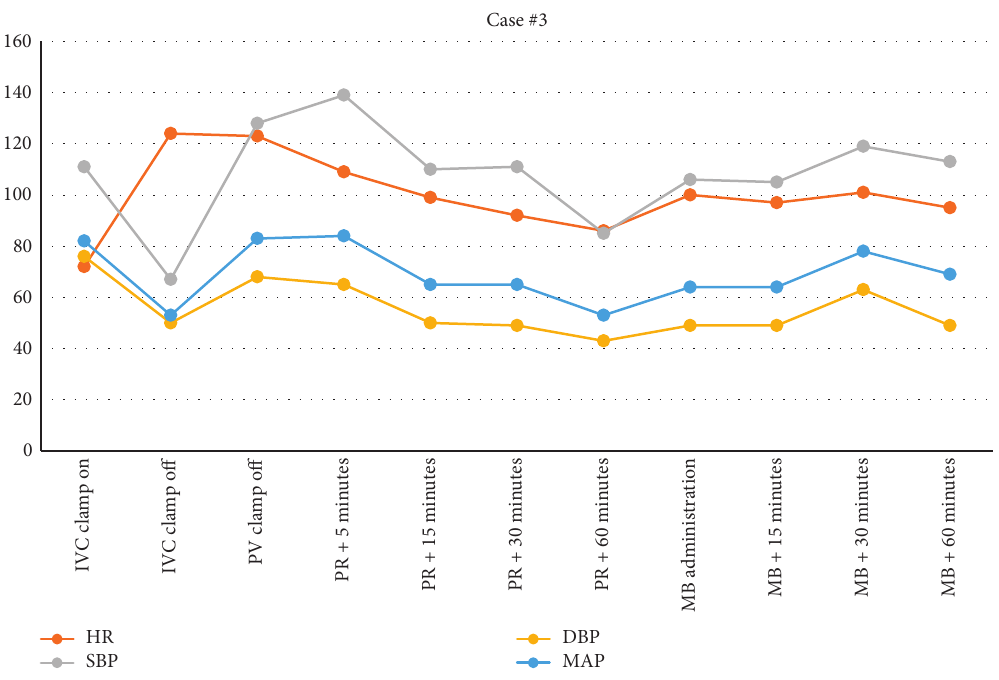
Figure 5: Vital signs from IVC clamp until 90 minutes following MB administration.